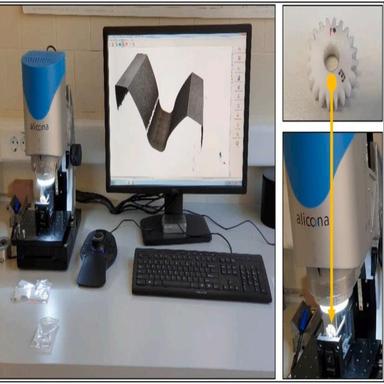
Optical scanning of a polymer gear.